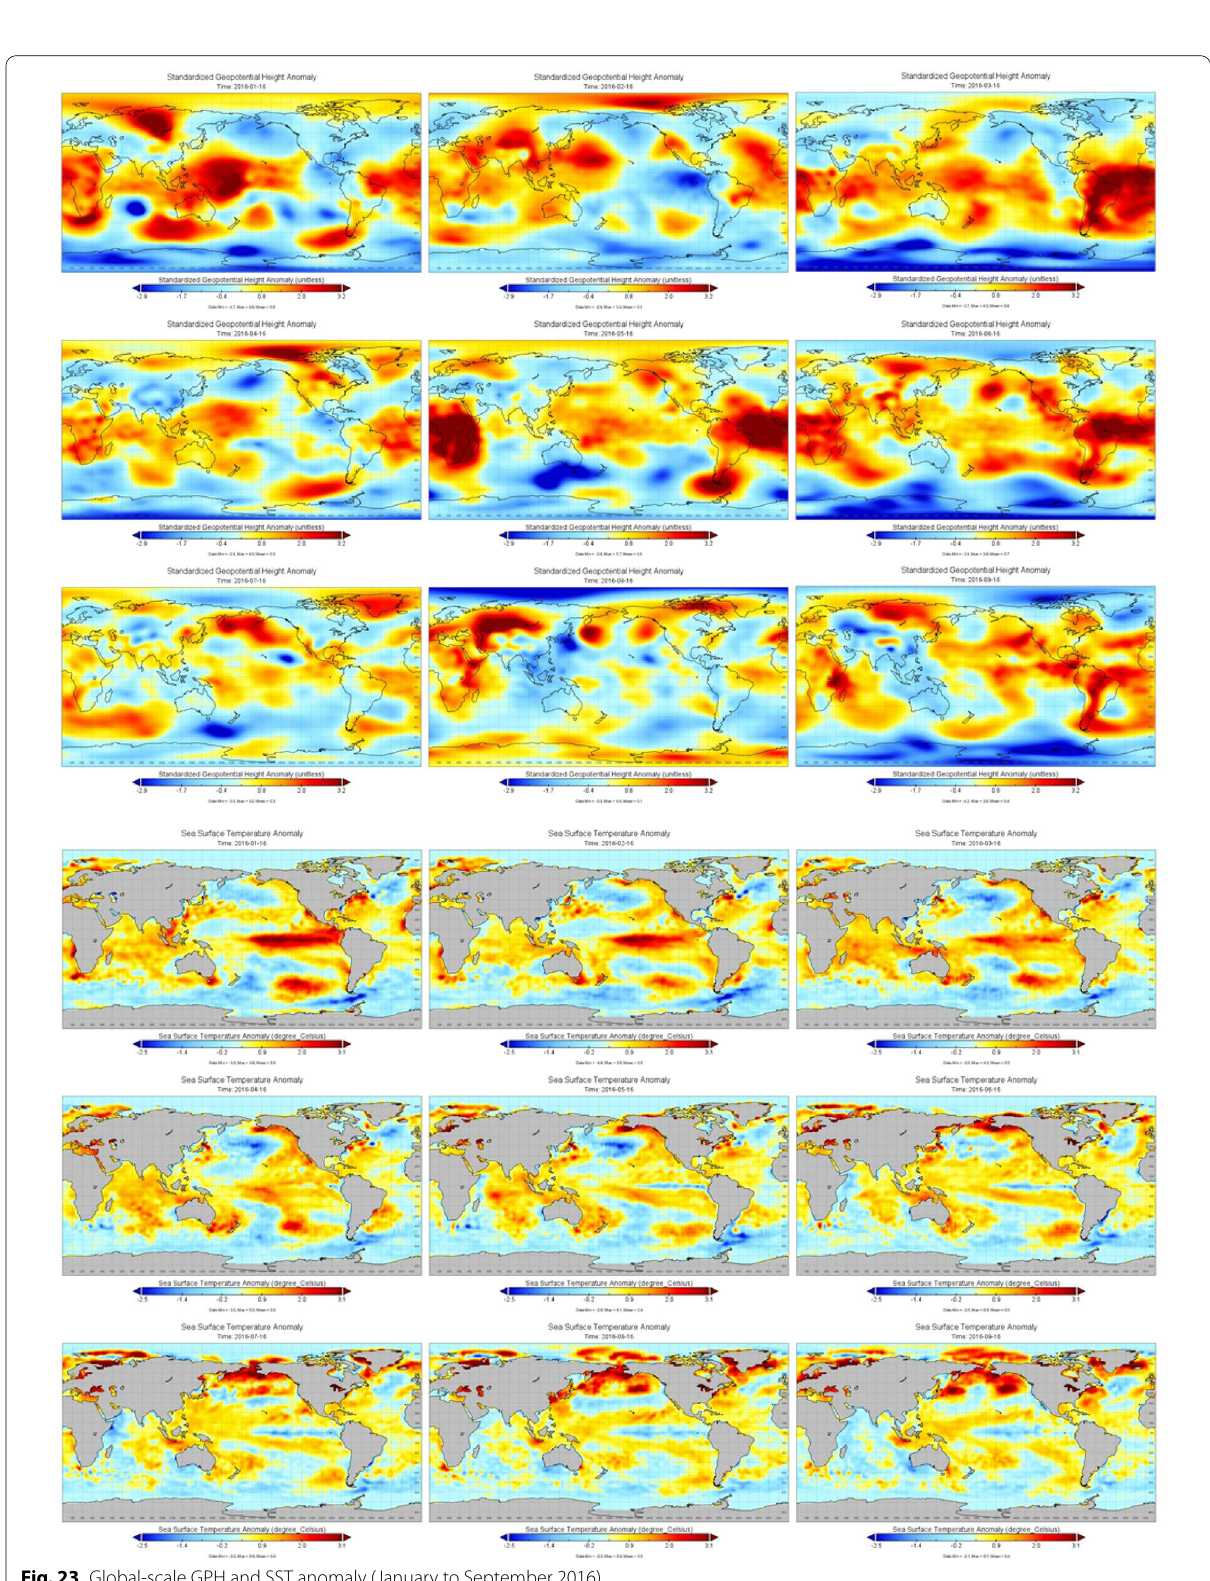
Fig. 23 Global-scale GPH and SST anomaly (January to September